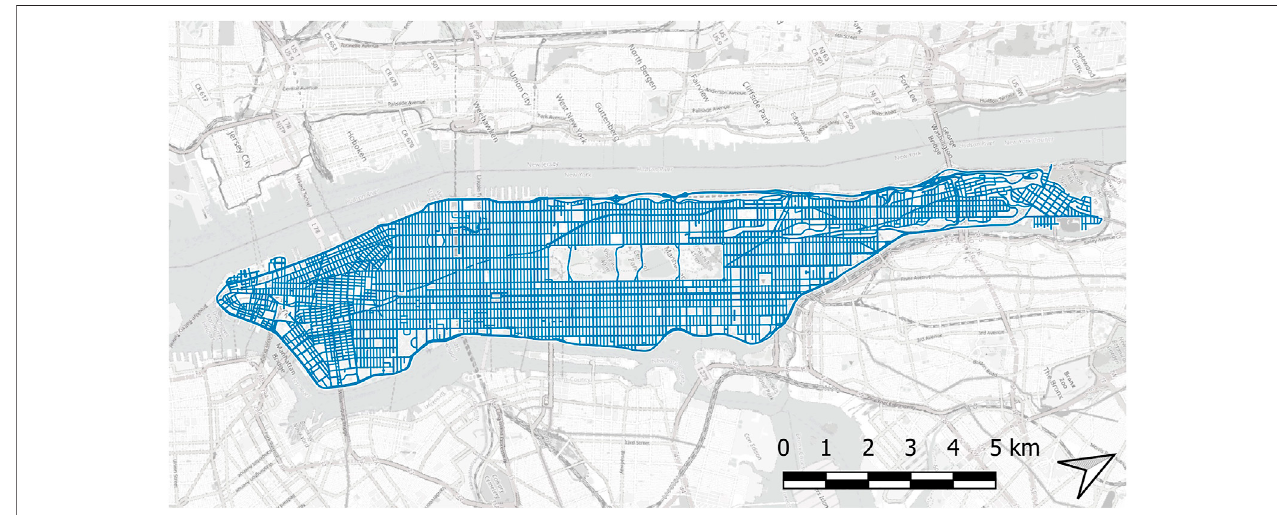
FIGURE 5 | Street network of Manhattan, NYC used in the case